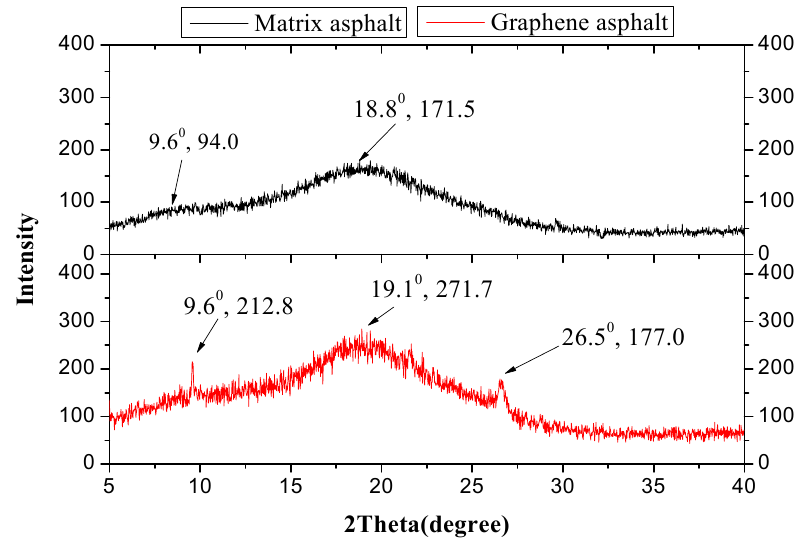
Figure 5. XRD test spectrum of matrix asphalt and GMA.